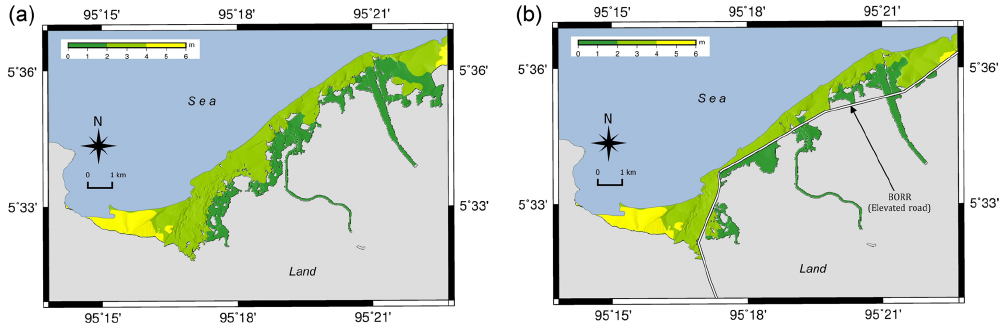
Figure 9. Comparison of maximum tsunami inundation depths generated by the 8.5 M w earthquake with conditions without BORR (a) and with BORR (b) .